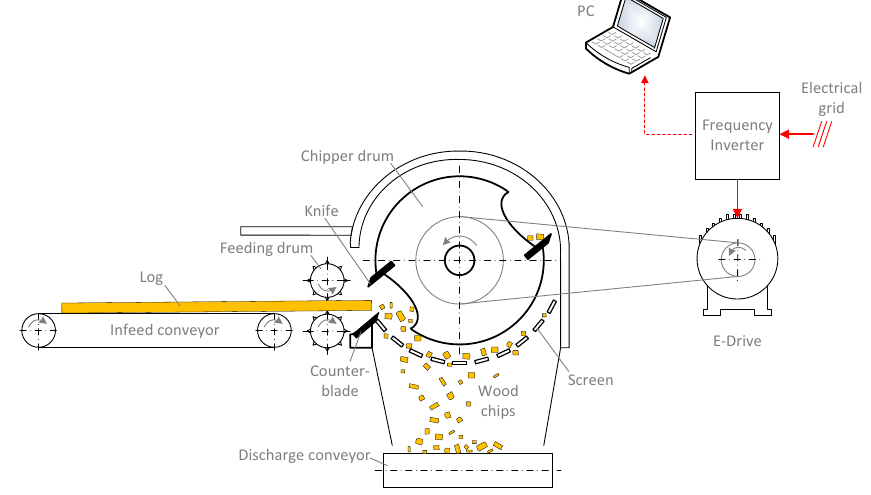
Figure 2. Test stand for determining the specific chipping energy demand.